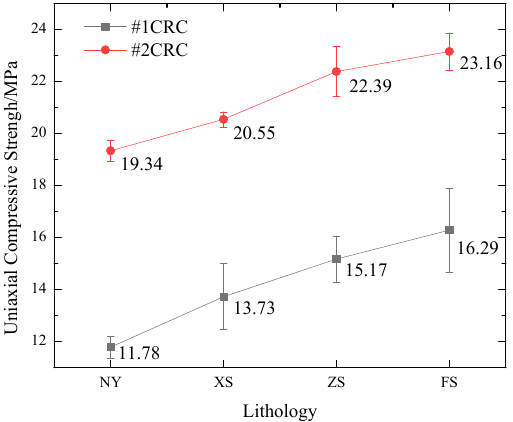
Figure 5. The compressive strength of the CRC specimens.